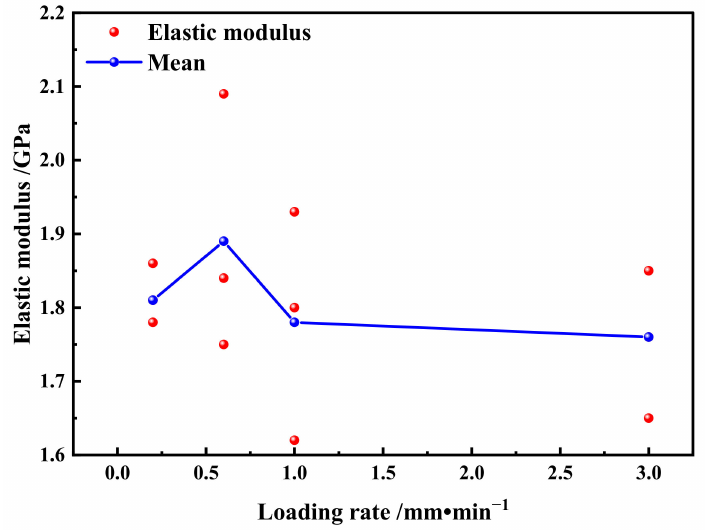
Figure 4. Correlation between elastic modulus and loading